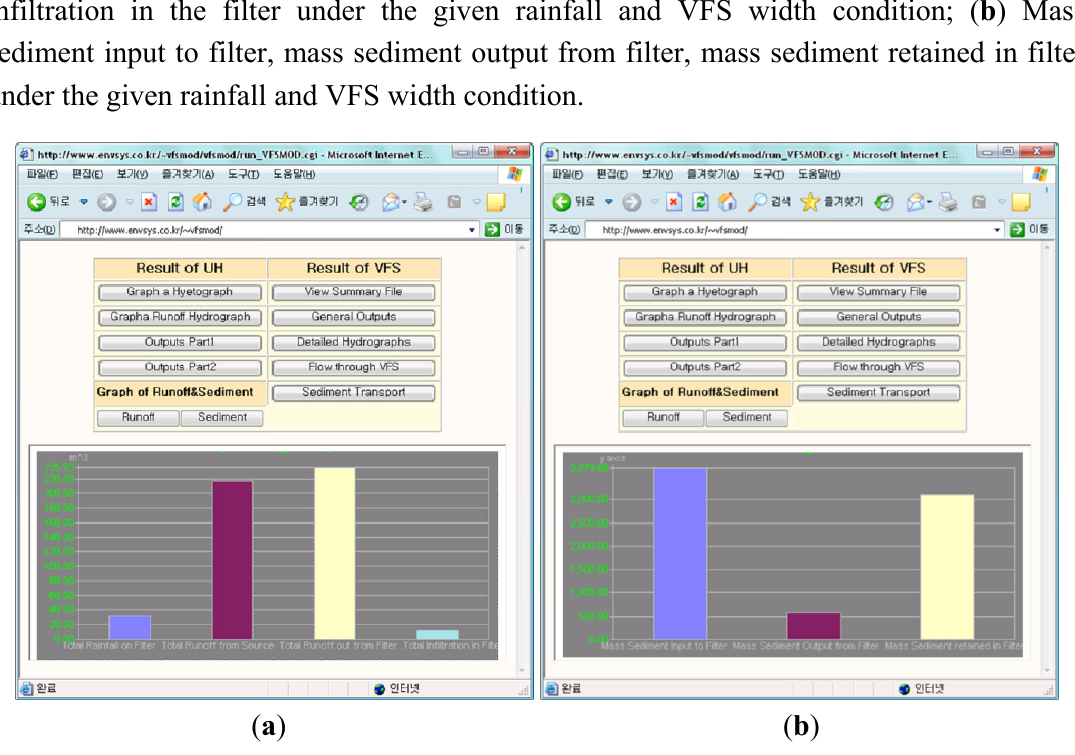
Figure 11. Single Storm Event Analysis (SSEA) output of the Web GIS-based VFSMOD